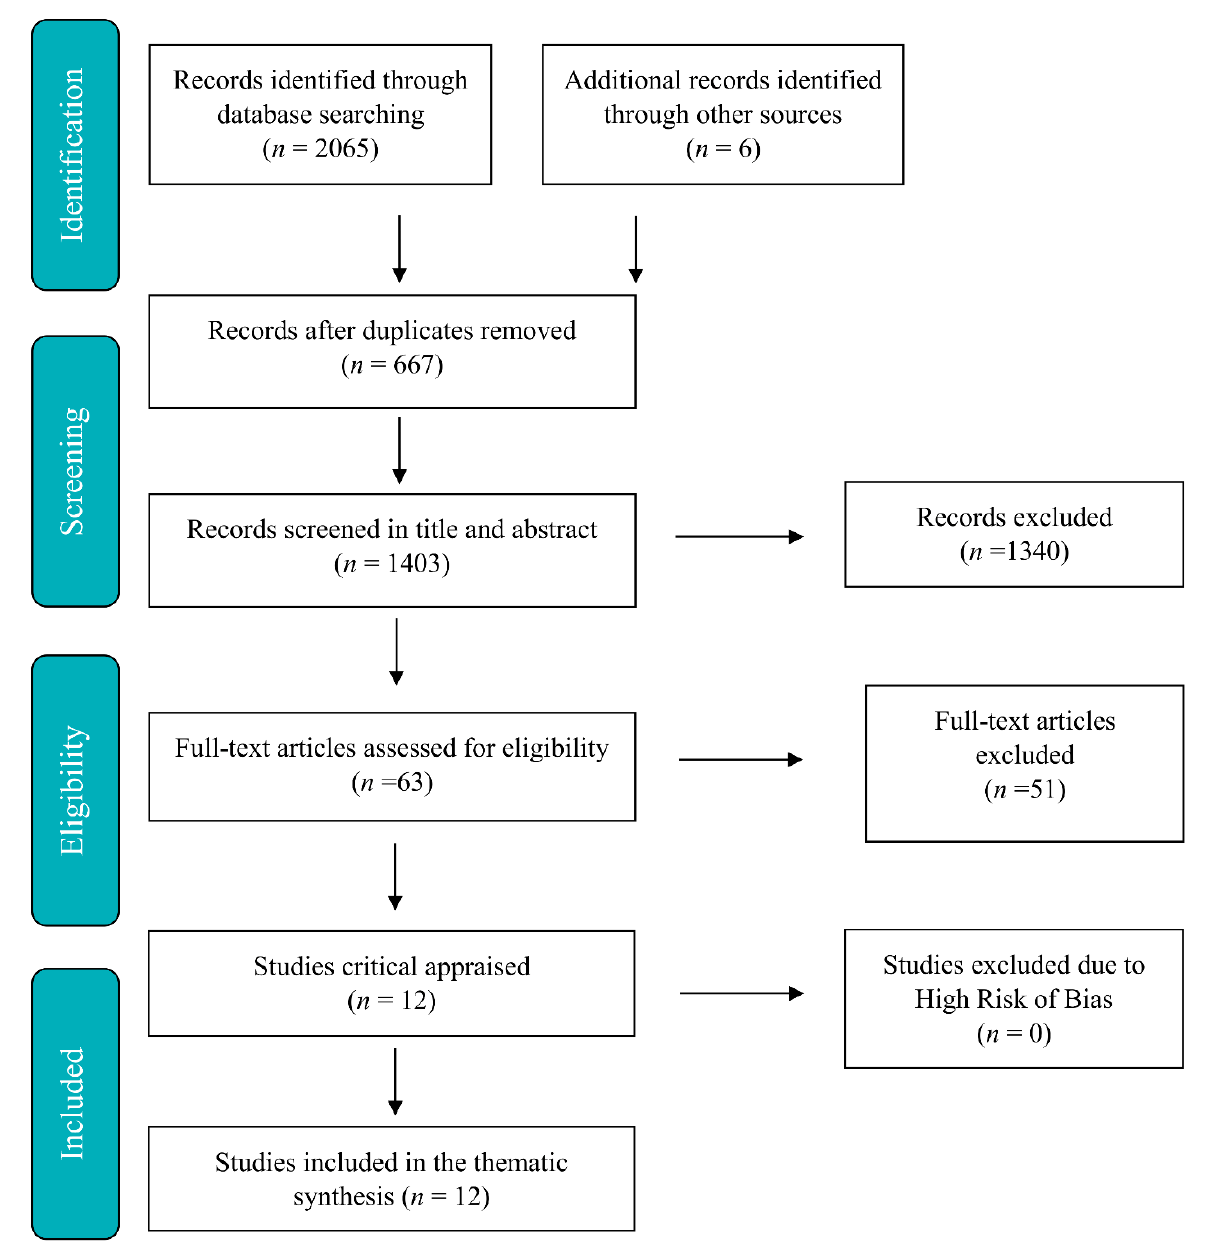
Figure 1. The PRISMA flow diagram.